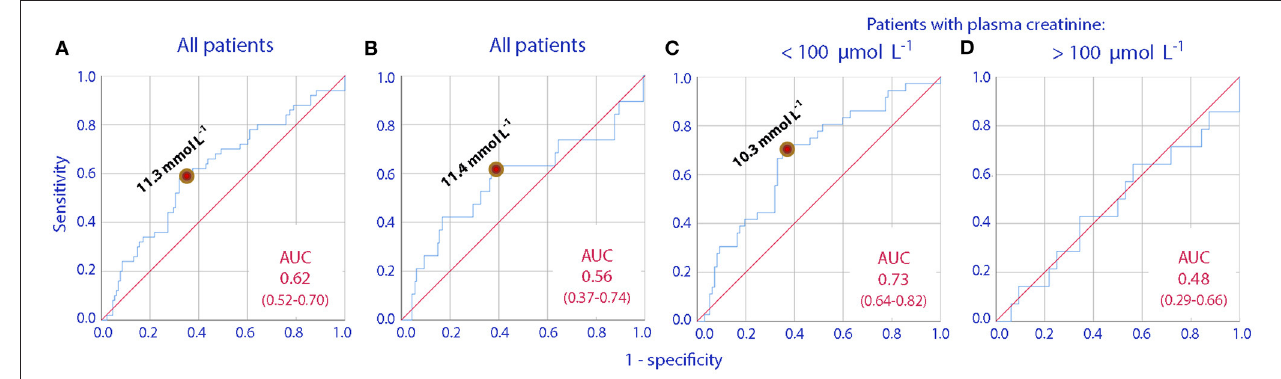
FIGURE 1 | Receiver operating curves (ROC) showing how increasing urinary creatinine concentrations can predict a postoperative increase in plasma creatinine by (A) > 25% in all patients, (B) > 50% in all patients, (C,D) > 25% in patients who have plasma creatinine concentrations lower or higher than 100 µ mol/L before the initiation of surgery. The area under the curve (AUC) and its 95% confidence interval are given in each